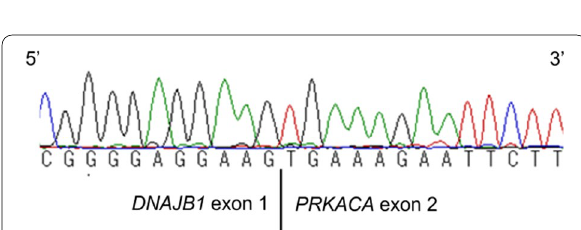
Fig. 4 With RT-PCR using FFPE tissue, DNAJB1-PRKACA fusion gene was